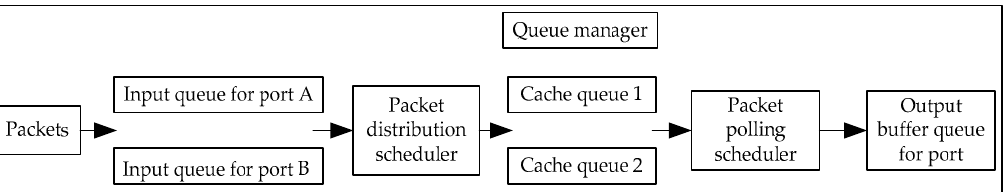
Figure 4. The process of packet processing.